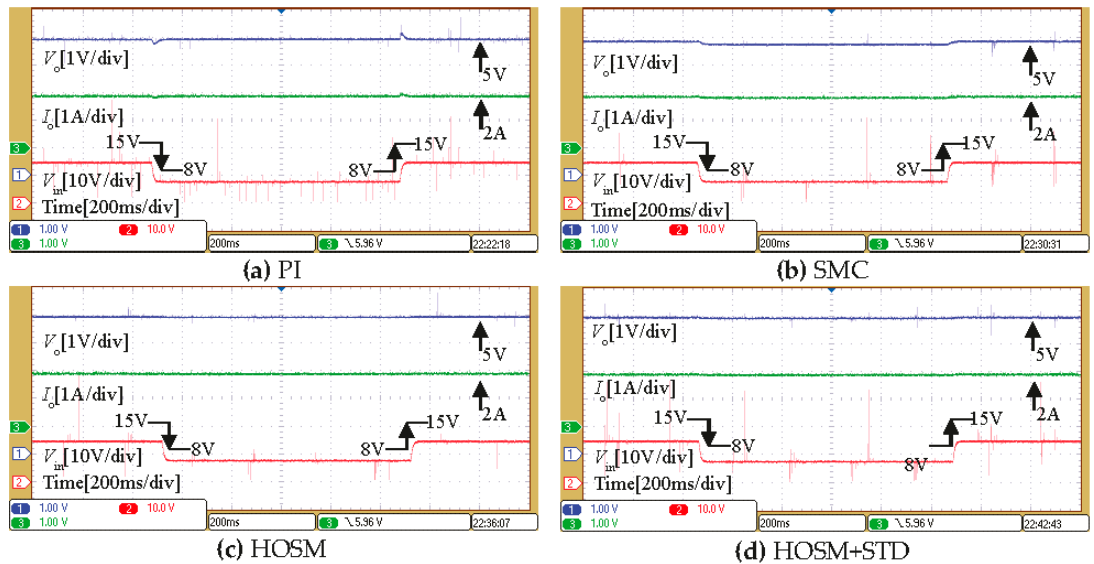
Figure 7. Experimental results of output voltage for buck converter under step input voltage perturbation ( V in = 15 V → 8 V → 15 V, R = 2.5 Ω ) with different controllers: Blue Channel 1 ( top line) output voltage V o (1 V/div), Green Channel 3 ( middle line) load current I o (1 A/div), Red Channel 2 ( bottom line) input voltage V in (10 V/div).